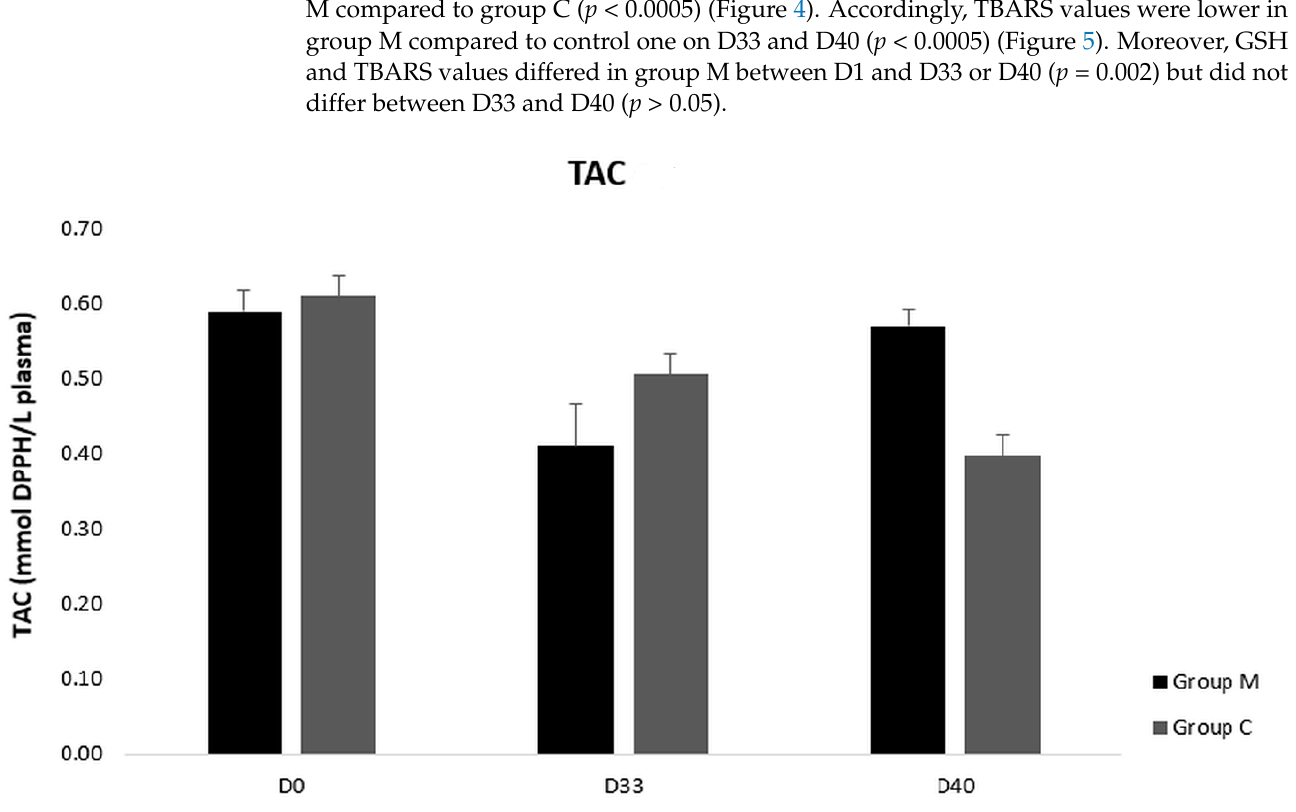
Figure 4. Glutathione (GSH) levels in blood plasma of group M (melatonin) and group C (control) at three time points of the study. a: Difference between the two groups, b: Difference between the three time points in group M or group C; p ≤ 0.05.